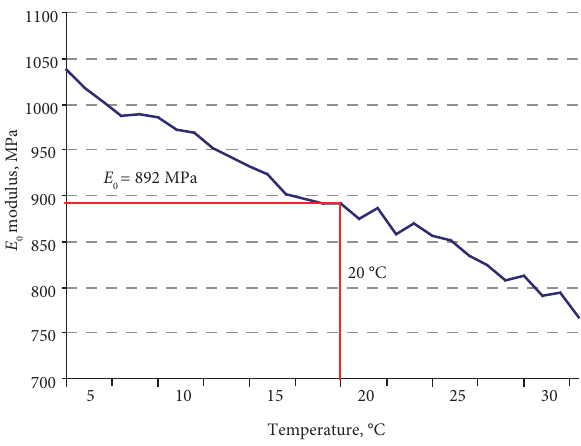
Fig. 3. E modulus values obtained during research 0